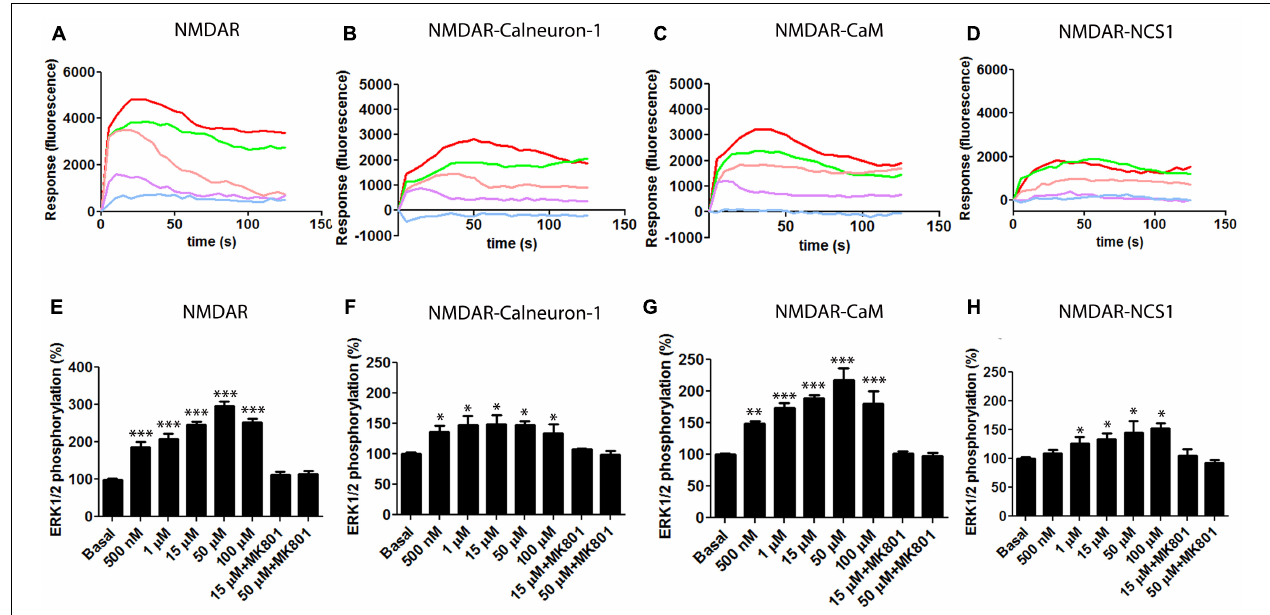
FIGURE 2 | NMDAR -mediated signaling in the presence of calcium sensors. (A–D) HEK-293T cells were transfected with the cDNAs for an engineered calcium sensor, 6GCaMP (0.5 µ g), GluN1 (0.4 µ g), GluN2B (0.25 µ g), and calneuron-1 (0.5 µ g) (B) , CaM (0.3 µ g) (C) , NCS1 (0.3 µ g) (D) , or all three (A) . Cells were treated with different concentrations of NMDA [500 nM (purple), 1 µ M (pink), 15 µ M (green), and 50 µ M (red)] or pretreated with the NMDAR specific antagonist MK-801 (10 µ M) followed by 15 µ M NMDA stimulation (blue). Representative traces of intracellular Ca 2 + responses over time are shown from five independent experiments. (E,F) HEK-293T cells were transfected with cDNAs for GluN1 (0.4 µ g), GluN2B (0.25 µ g), and calneuron-1 (0.5 µ g) (F) , CaM (0.3 µ g) (G) , NCS1 (0.3 µ g) (H) , or all three (E) . Cells were treated with different concentrations of NMDA (from 500 nM to 100 µ M) or pretreated with the NMDAR specific antagonist MK-801 (10 µ M) followed by treatment with NMDA (15 or 50 µ M) and ERK1/2 phosphorylation levels were measured. Values are the mean ± SEM ( n = 7). Significant differences over basal condition were calculated by one-way ANOVA and Bonferroni post hoc test ( ∗ p < 0.05, ∗∗ p < 0.01, and ∗∗∗ p <